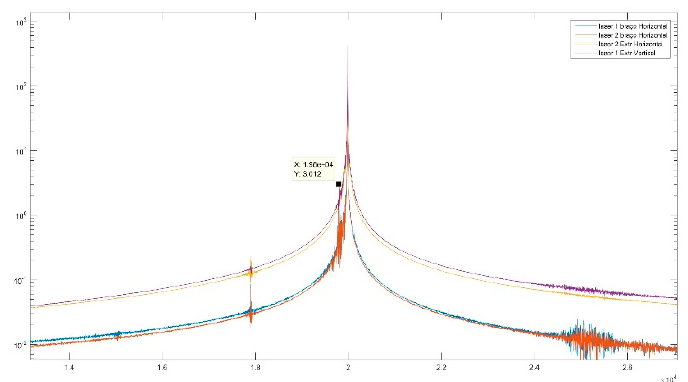
Figure 28. FRFs at: axial direction on the vertical arm’s end (purple); axial direction on the horizontal arm’s end (yellow); transverse direction at the horizontal arm’s sides (blue and orange).